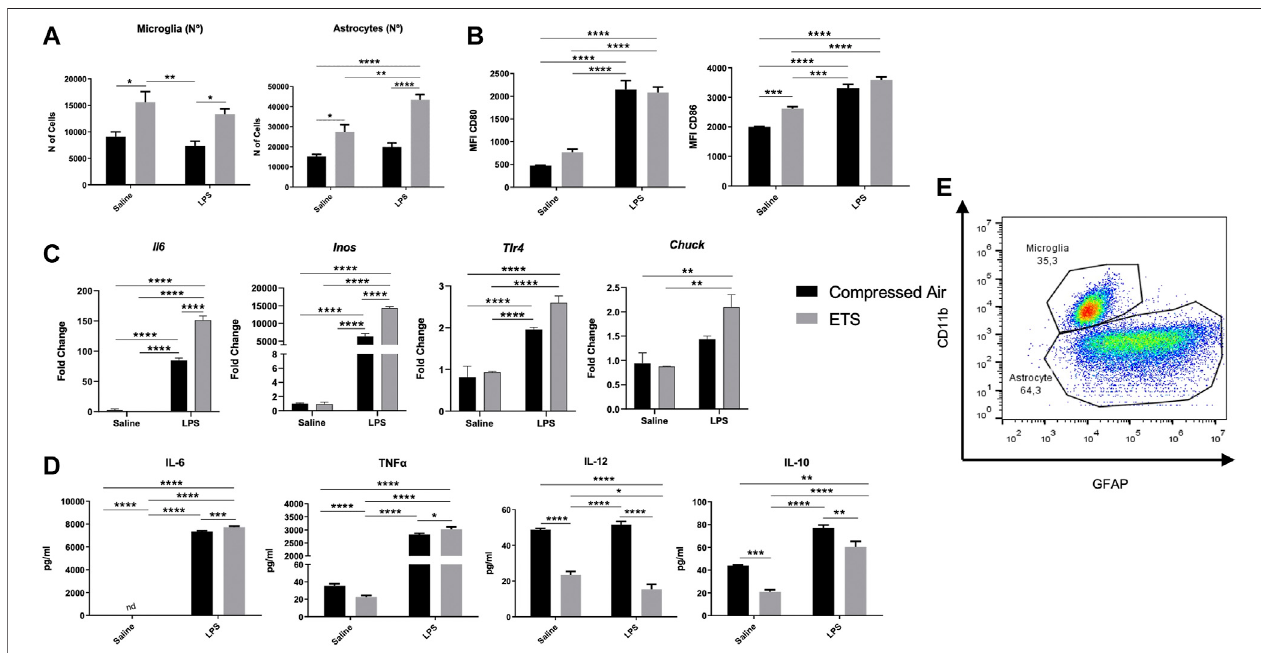
FIGURE 2 | Enhanced glia cell culture from C57Bl/6 mice offspring exposed or not to environmental tobacco smoke in utero . After maturation, cells were challengedornotwithLPS. (A) Flowcytometry analysisofmicroglia(CD11b)andastrocytes (GFAP)in enhancedgliacellculture, graphsforthetotalnumber ofcells; (B) mean fl uorescence intensity (MFI) for CD80 and CD86; (C) Gene expression analysis by PCR; (D) Cytokine ’ s quanti fi cation in culture supernatant; (E) Gate representativeofcellfrequencyin enhancedgliacellculture. Statisticalanalysis:Two-wayANOVAandTukey ’ spost-hoc.Dataareexpressedasmean ± SEM.* p < 0.05, ** p < 0.01, *** p < 0.001, **** p < 0.0001. The black bar represents exposure to compressed air and gray bar represents exposure to